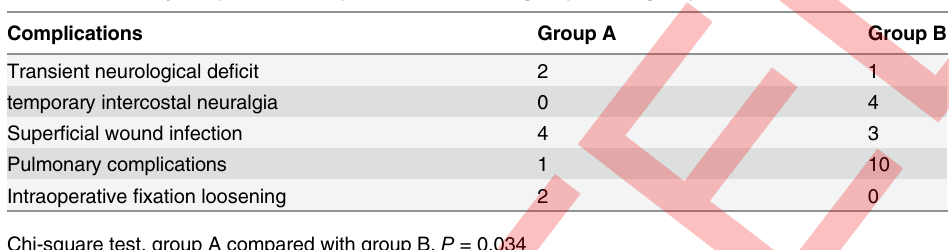
Table 5. Summary of operative complications between group A and group